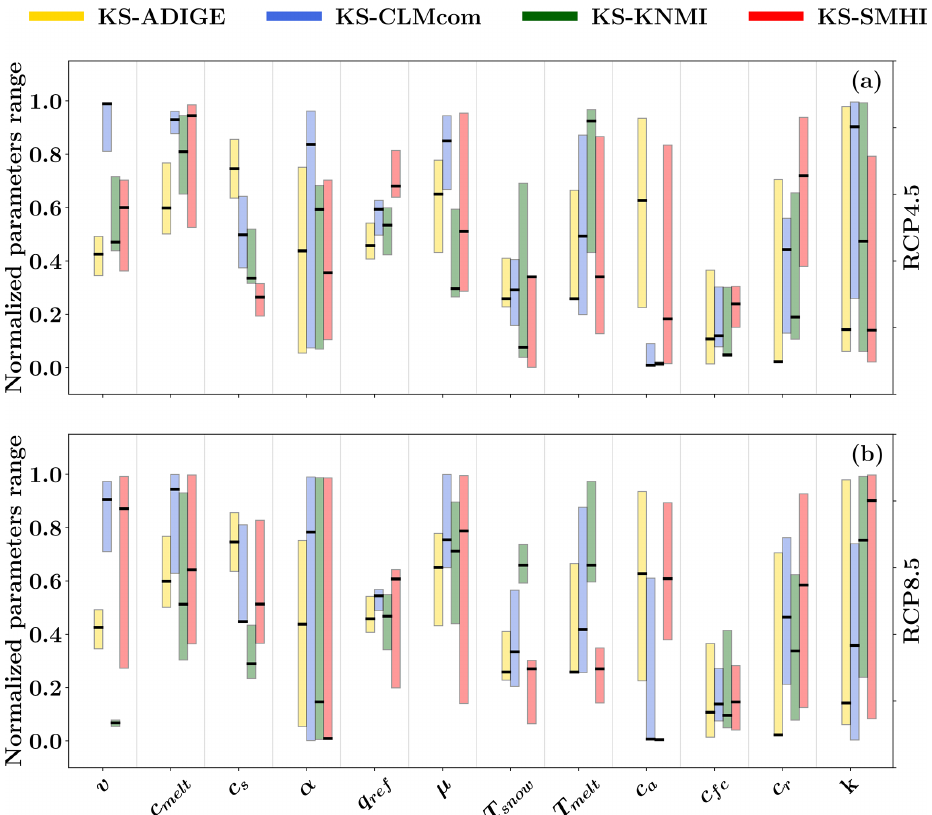
Figure 7. The range ( ¯ d ) between the maximum and minimum value of each parameter associated with the 200 simulations presenting the highest efficiency plotted as a normalized range with respect to the parameter range presented in Table 1. Calibrations are conducted for the three different CMs under the respective (a) RCP4.5 and (b) RCP8.5 emission scenarios with reference to the KS metric. Bold horizontal segments indicate the optimal parameter sets for all